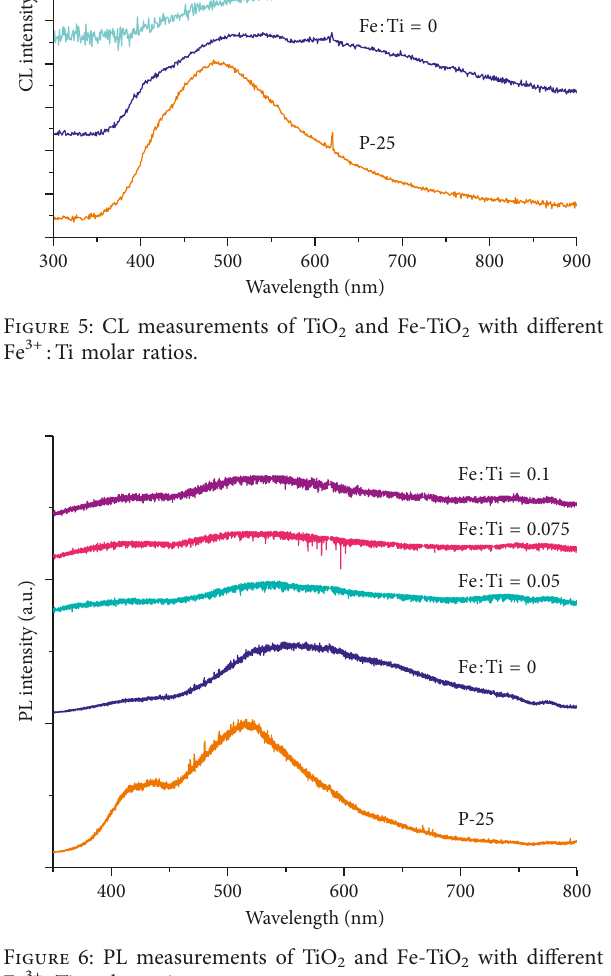
2 and Fe-TiO 2 with different